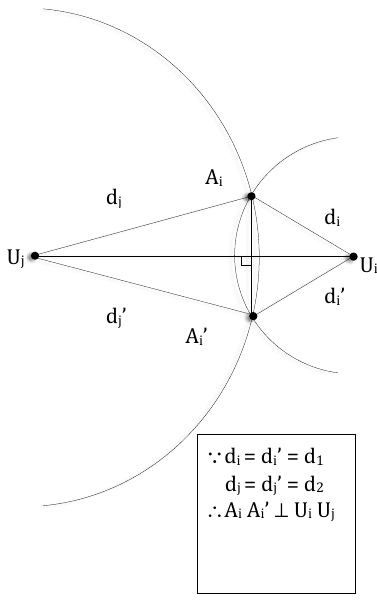
Figure 3. Let A i be an evil-ring attacker and A (cid:48) be its fake location. Any sensor on the line that is i perpendicular to A i A (cid:48) and passing through A i A (cid:48) ’s midpoint cannot detect A i as an evil-ring attacker. i i Given no three sensors are collinear (by assumption), there is no other location-unknown sensor other than U i and U j that can be fooled by A i